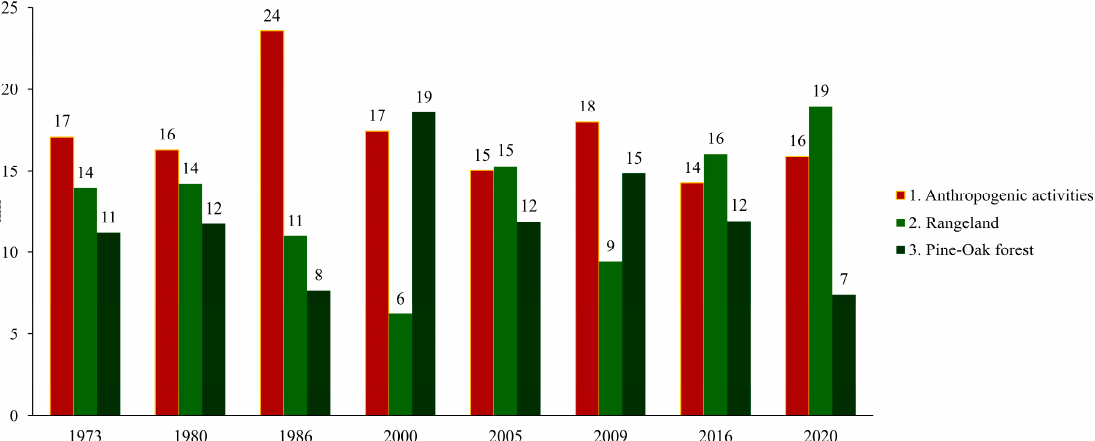
Figure 15. Land use coverage and changes in the study period, San Vicente, Palmillas, Tamaulipas,